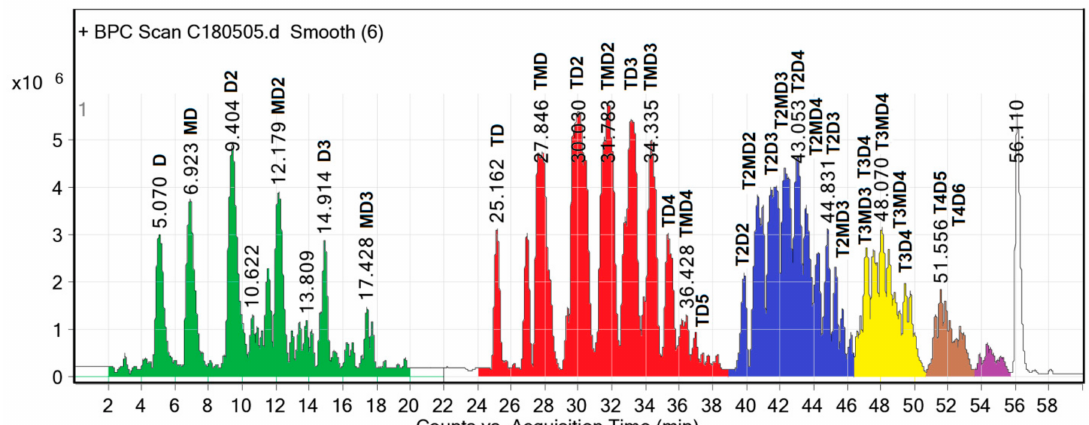
Figure 3. Total ion current chromatogram from the LC experiment of the oligodiol DZS sample.